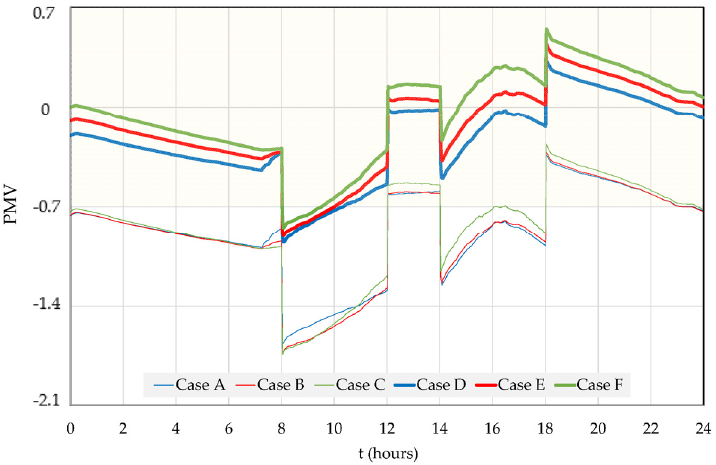
Figure 23. Evolution of PMV index for the six cases studied. The comfort zone according to Category